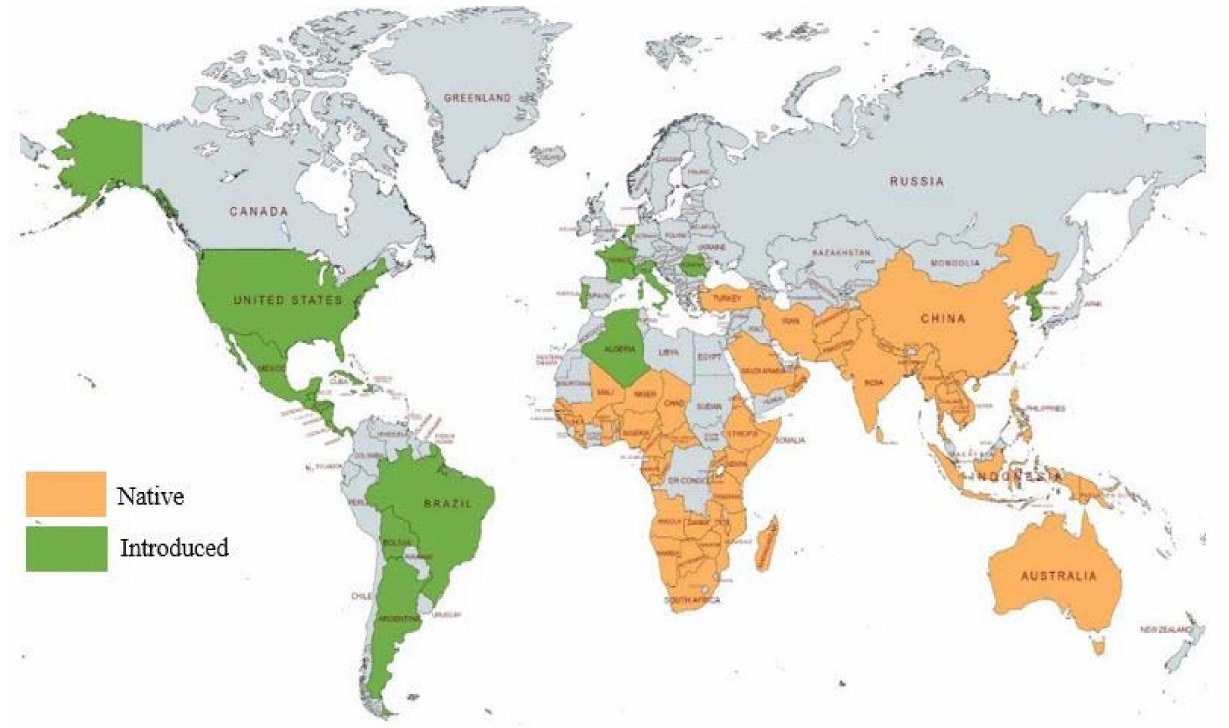
Figure 1. Global distribution of genus Jasminum (Created with